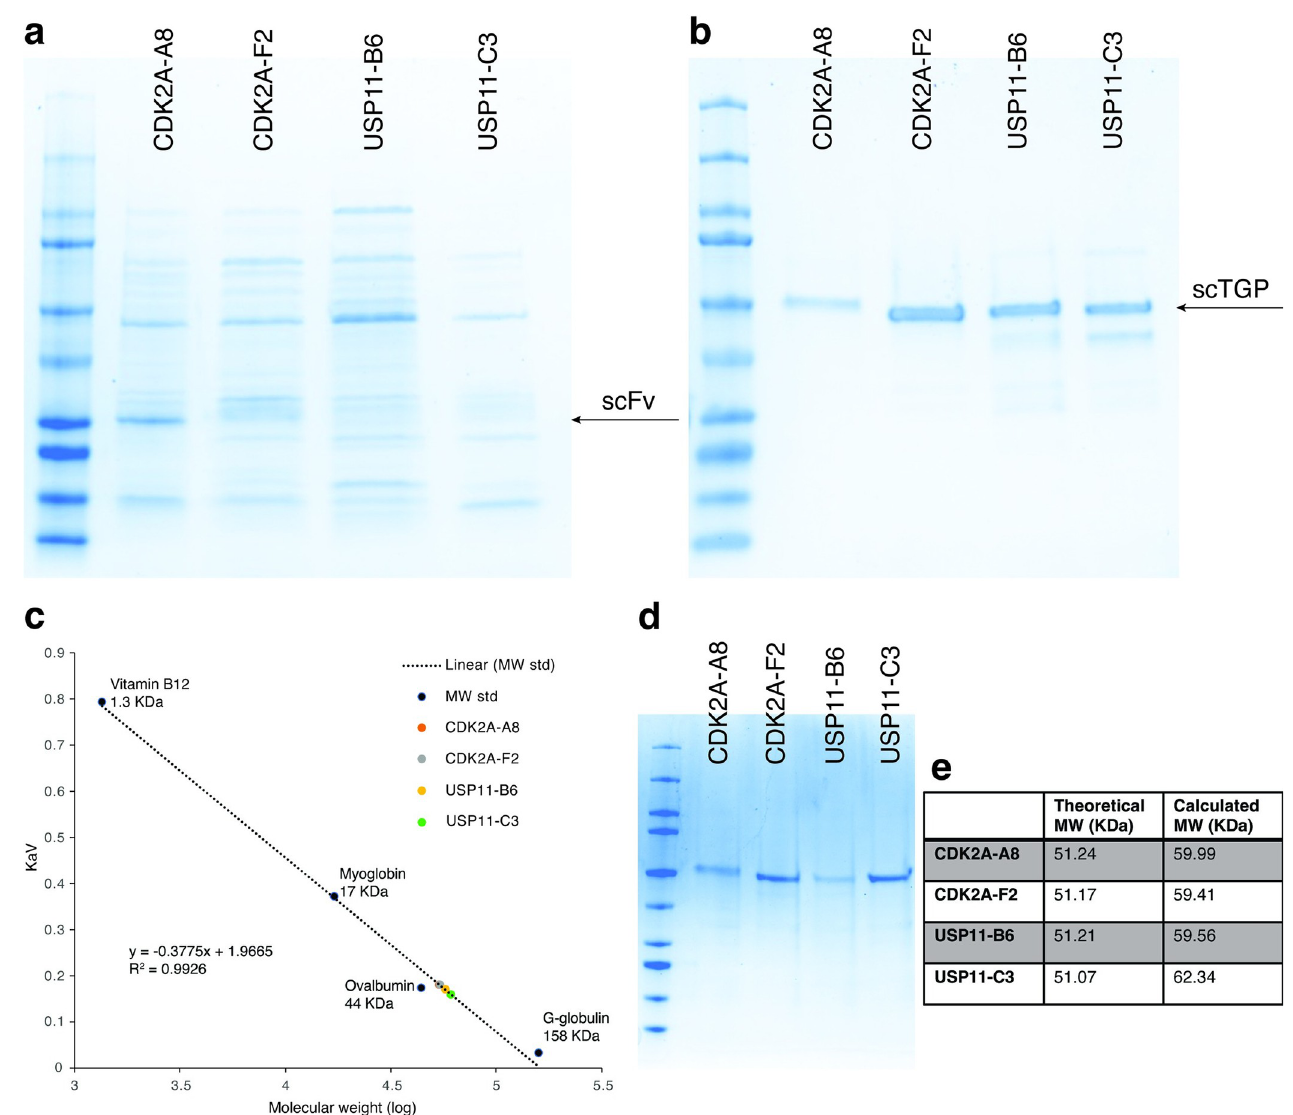
Fig 6. Comparison of the quality of purified scFvs and scTGPs. Panel a) shows scFvs and b) shows scTGPs purified by His tag affinity chromatography followed by TEV digestion. The expected molecular weights for scFvs are ~30 K D and for scTGPs ~51 K D . c) Gel filtration chromatography results for the scTGP proteins. The proteins ran as monomers with calculated Mw 59–62 KDa based on standard calibration curve (theoretical molecular weight is ~ 51 KDa). The dotted line is the calibration curve calculated from the data for protein standards (R2 = 0.9926). The main scTGP peaks are shown as colored dots. d) SDS-PAGE shows protein samples ran as a single band e) . Comparison of theoretical and calculated